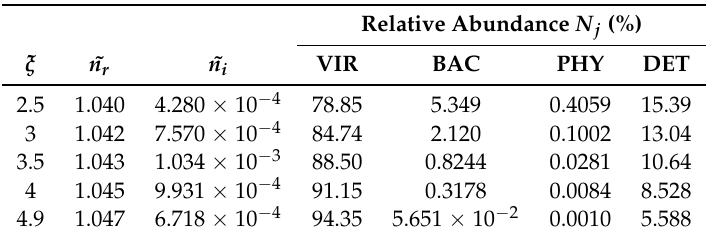
Table 3. Relative abundance of viruses (VIR), bacteria (BAC), phytoplankton (PHY), and organic detritus (DET) with the corresponding bulk refractive index (Equations (9) and (10)) for the water body with no bloom conditions and no minerals (oligotrophic-like).